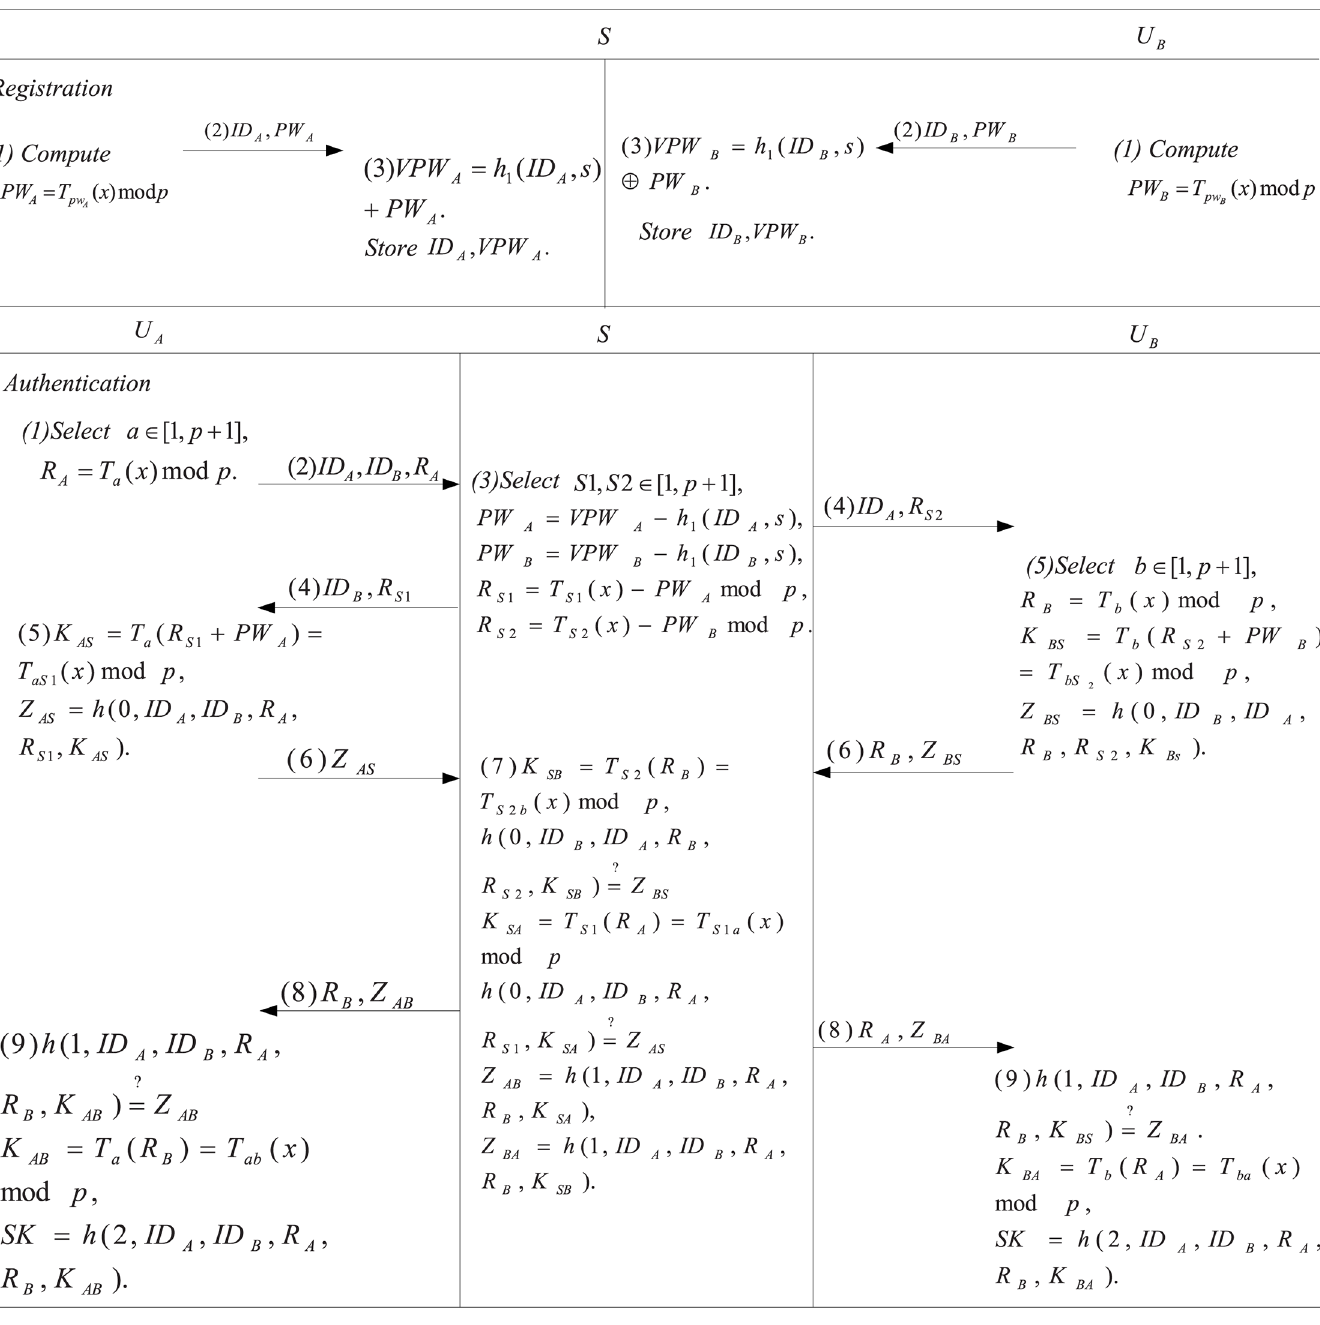
Fig 1. Mutual authentication and key agreement of Xie et al. ’ s